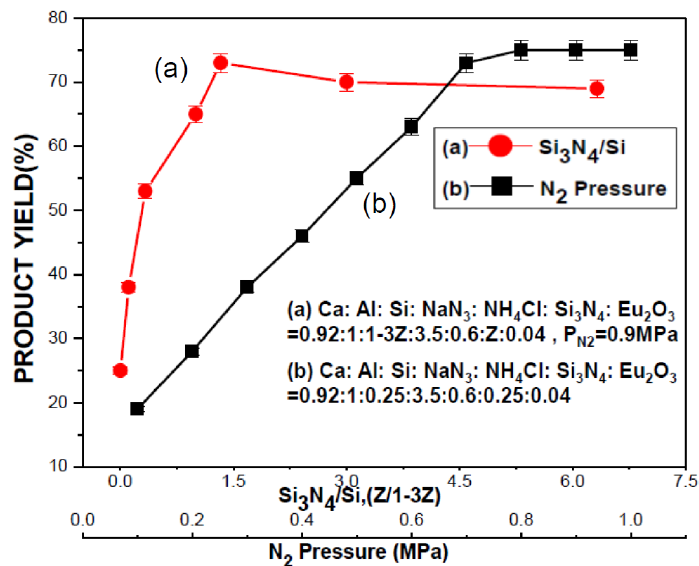
Figure 7. Effects of ( a ) Si 3 N 4 Content (expressed as the molar ratio of Si 3 N 4 /Si) and ( b ) N 2 pressure on the product